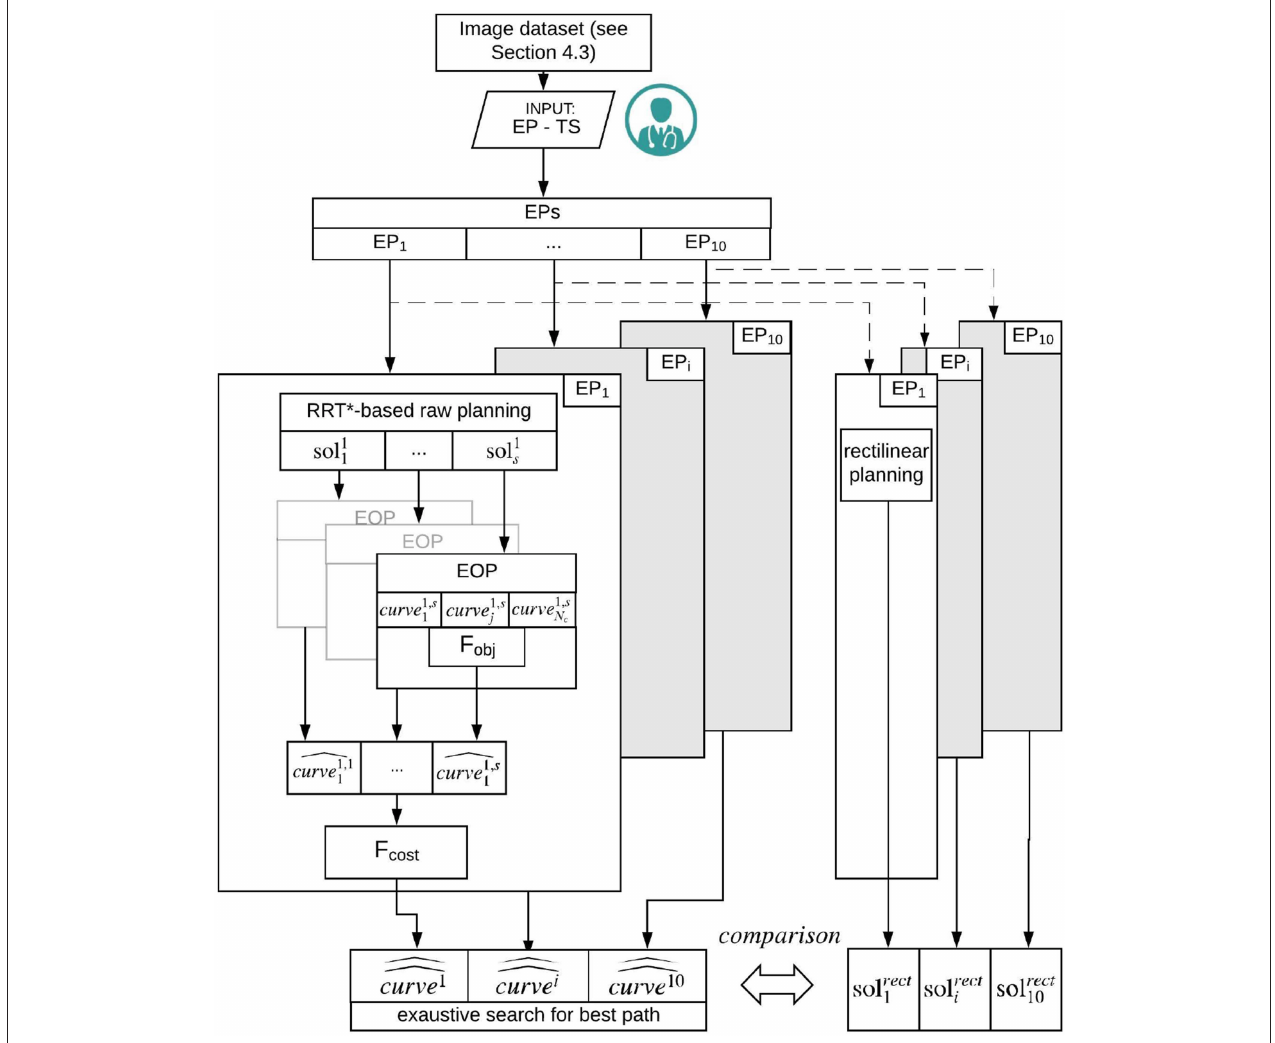
FIGURE 1 | Schematic representation of the workflow. From the segmented image dataset, 10 EPs are selected. On each EP, the RRT based raw planning is applied computing s { sol i s } solutions (section 3.2.1). Subsequently, an EOP is computed based on Fobj to be minimized. A number of feasible solutions {